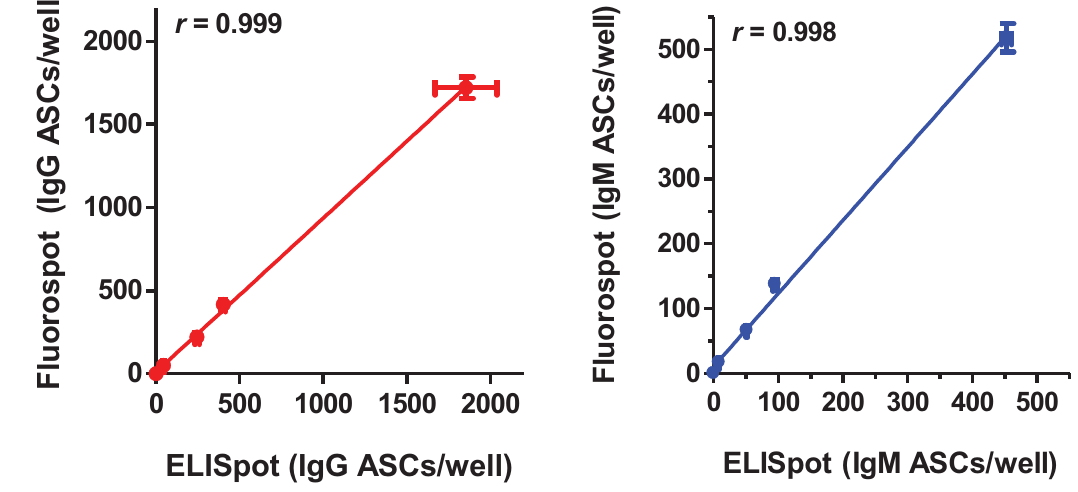
Figure 1. Correlation between antibody-secreting cell counts obtained with the traditional ELISpot and the novel B cell fluorospot assay. IgG ASCs (on the left) and IgM ASCs (on the right) counted with the ELISpot assay are plotted on the x -axis and those counted with the fluorospot assay in side-by-side experiments are plotted on the y